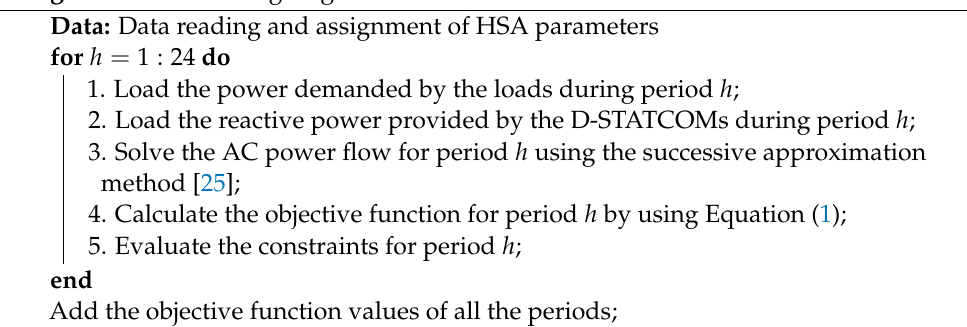
Algorithm 2: Slave stage algorithm: HSA Data: Data reading and assignment of HSA